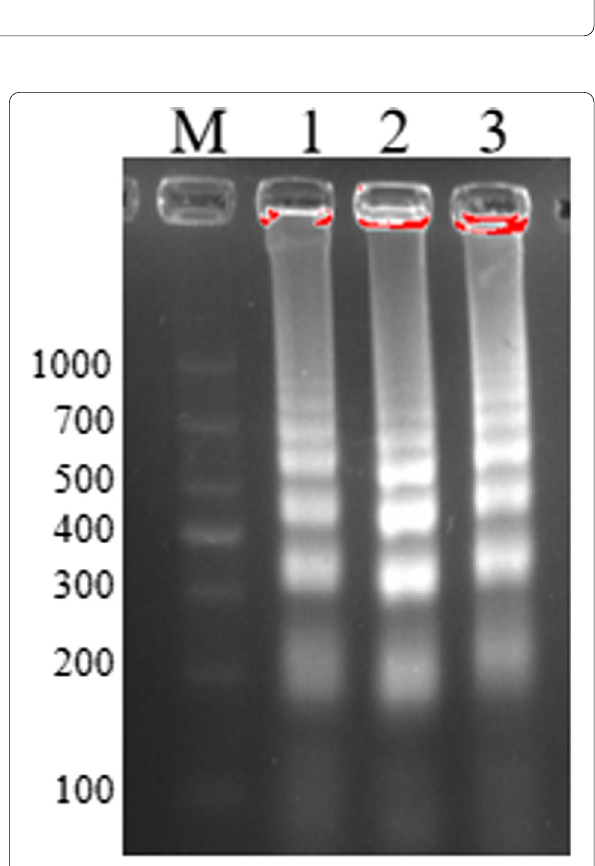
Fig. 2 MCDA primers screening. The amplification performance of three sets of MCDA primers were evaluated by agarose gel electrophoresis. Lane M, DNA maker DL1000. Lane1/2/3, the first pcsB-MCDA primer set, the second pcsB-MCDA primer set, the third pcsB-MCDA primer